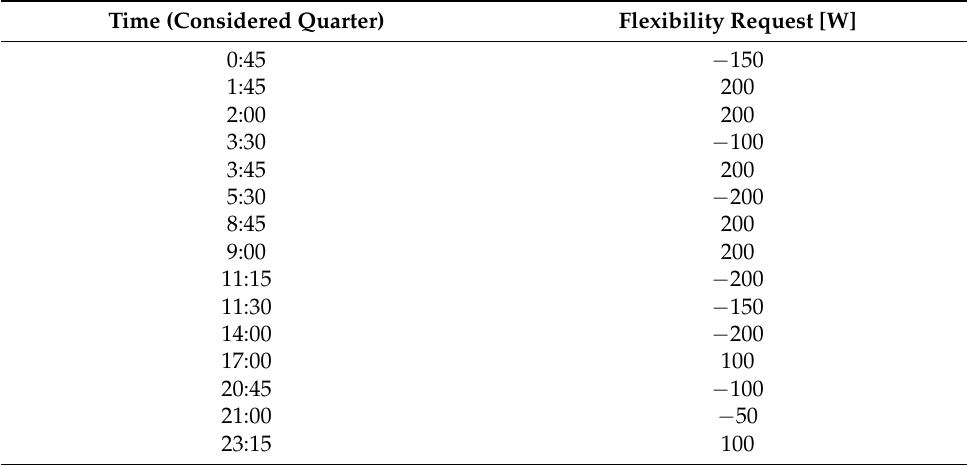
Table 2. Flexibility services requested to the